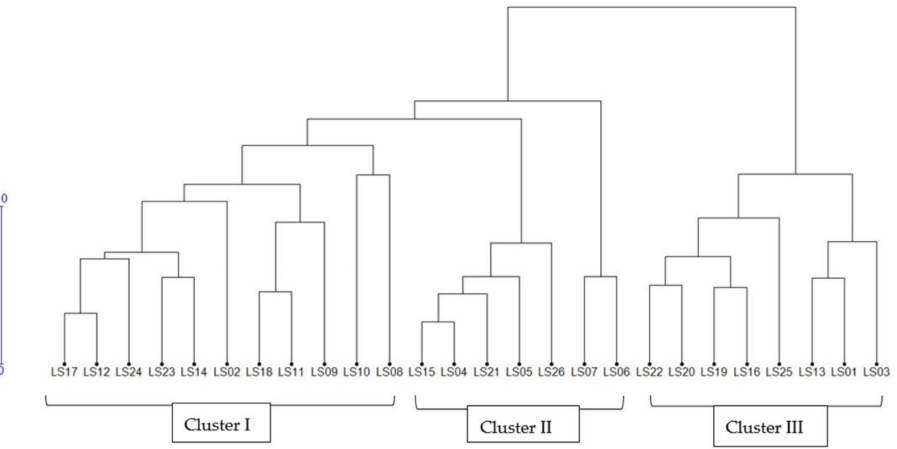
Figure 5. Hierarchical clustering of 26 okra accessions based on phenotypic traits evaluated under drought-stressed conditions.